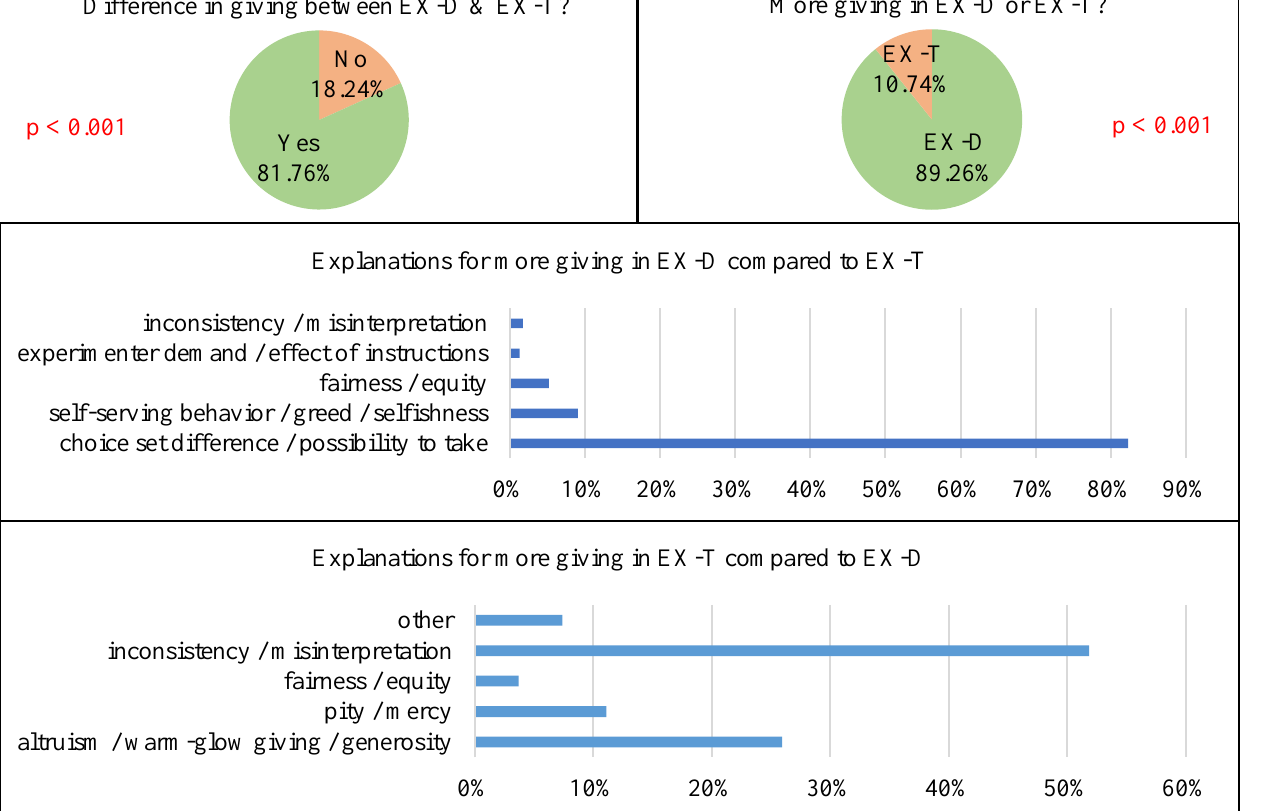
Figure 4. Survey results for Hypothesis 1 (endogenous games).